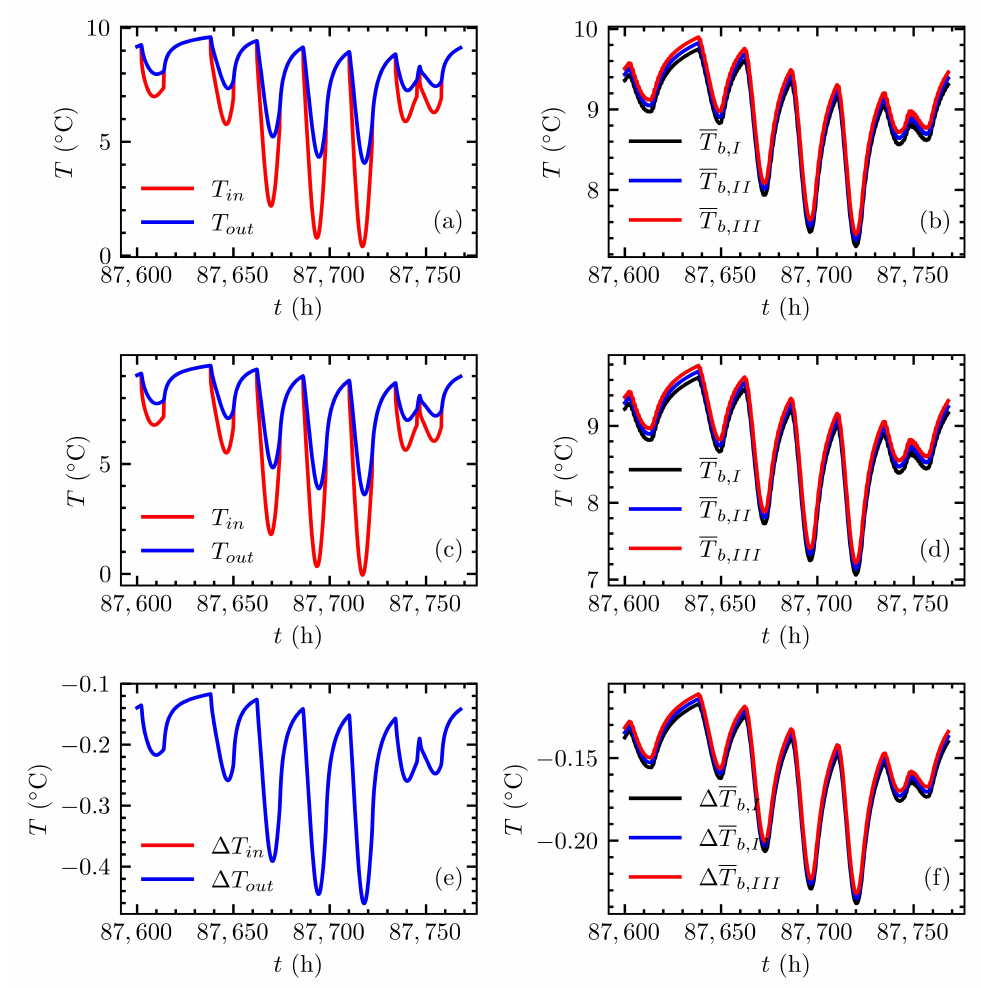
Figure 12. Comparison of predicted inlet and outlet fluid temperatures and borehole wall tem- peratures for each equivalent group ( I , II , III ) during the 7-day period: ( a , b ) proposed method, ( c , d ) FEA model, ( e ) errors of the inlet and outlet fluid temperatures, and ( f ) error of the borehole wall